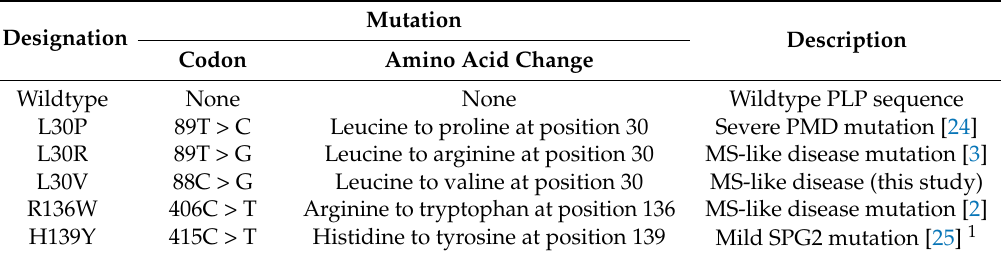
Table 3. PLP1 constructs used in the study.